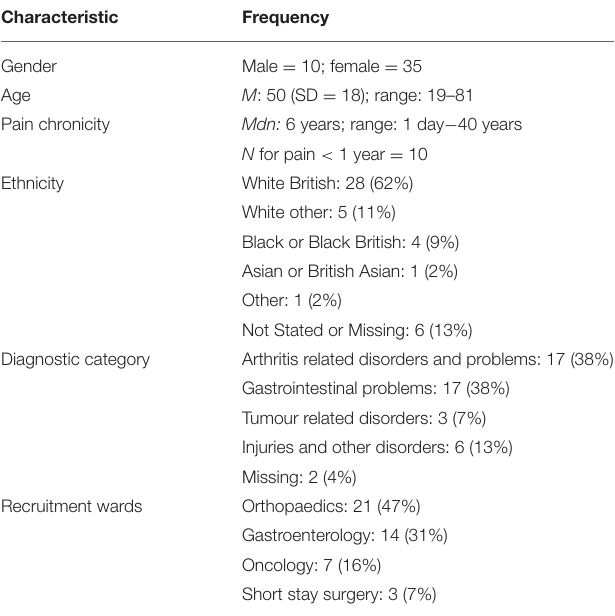
TABLE 1 | Participant sample